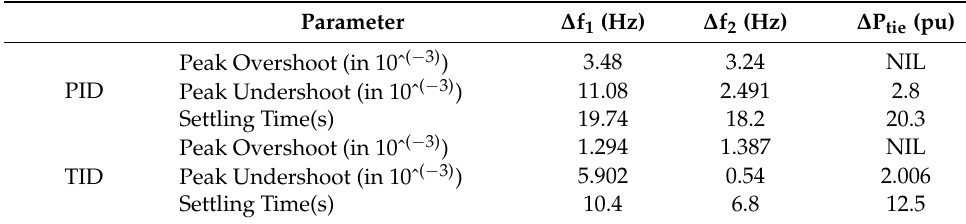
Table 4. Dynamic measures with PID and TID controllers.